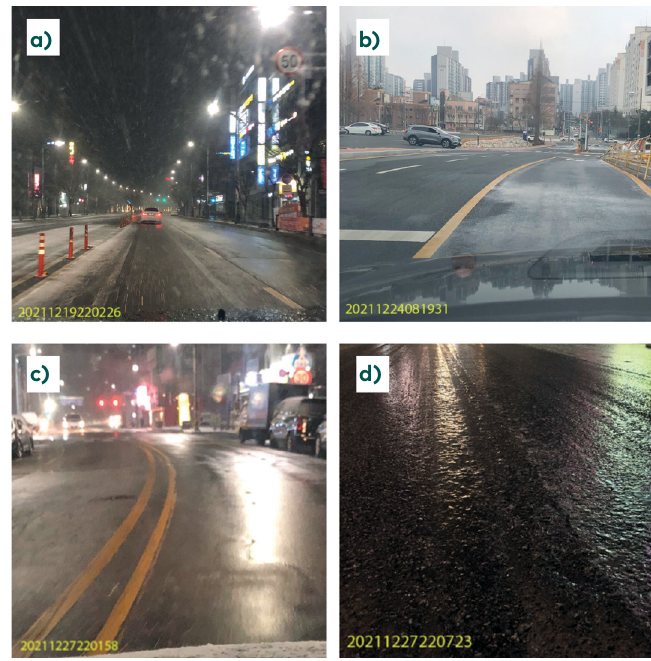
Figure 12. Real-time observations of road